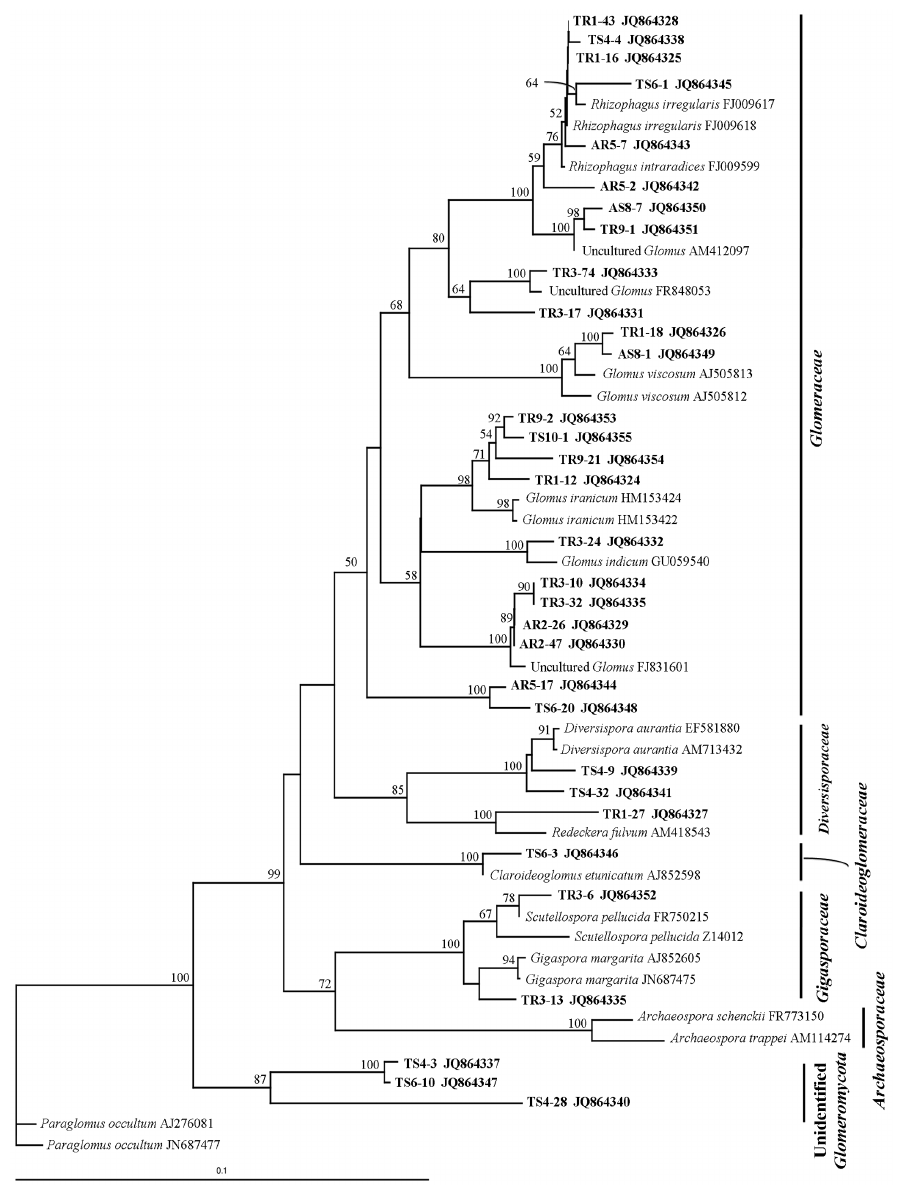
Figure 4. Neighbour-joining (NJ) phylogenetic tree of partial small subunit rRNA gene. Phylogeny was constructed using the region from NS31 to AML3. The percentage support values are based on 1000